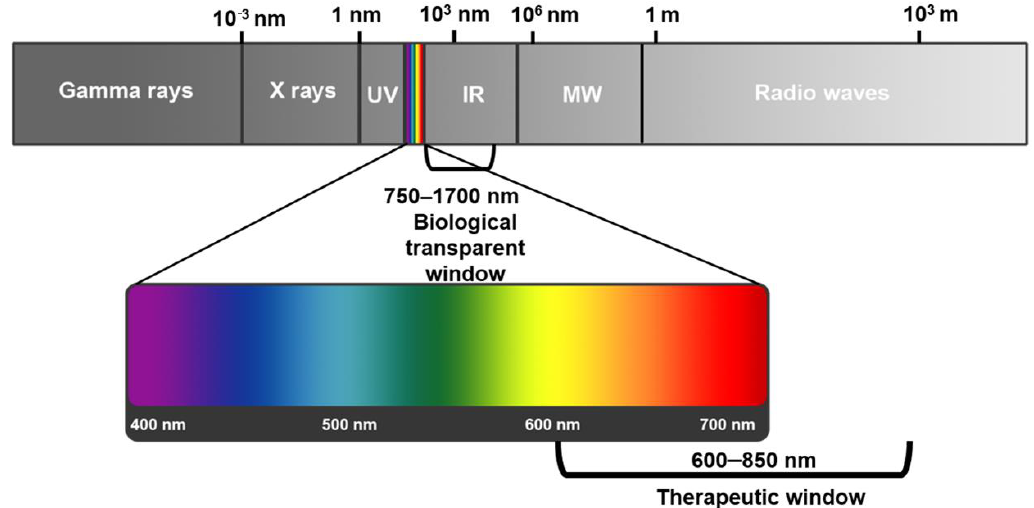
Figure 1. Electromagnetic spectrum showing the ideal phototherapeutic window for photodynamic therapy (PDT) treatment of cancer.